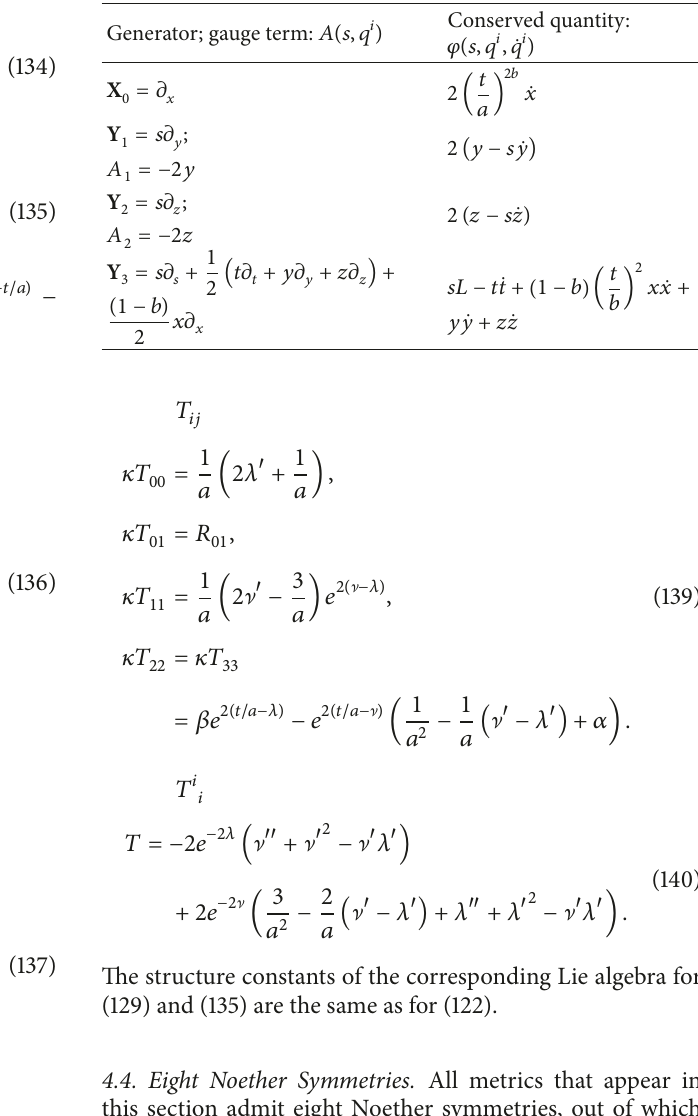
Table 22: Conserved quantities corresponding to each Noether